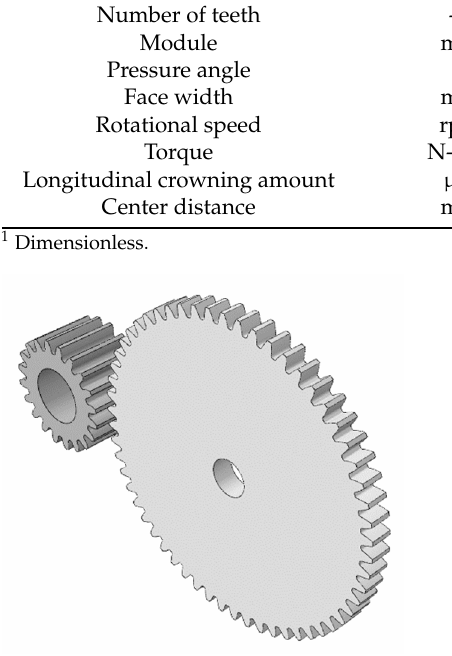
Figure 2. Three-dimensional model of spur gear pair.